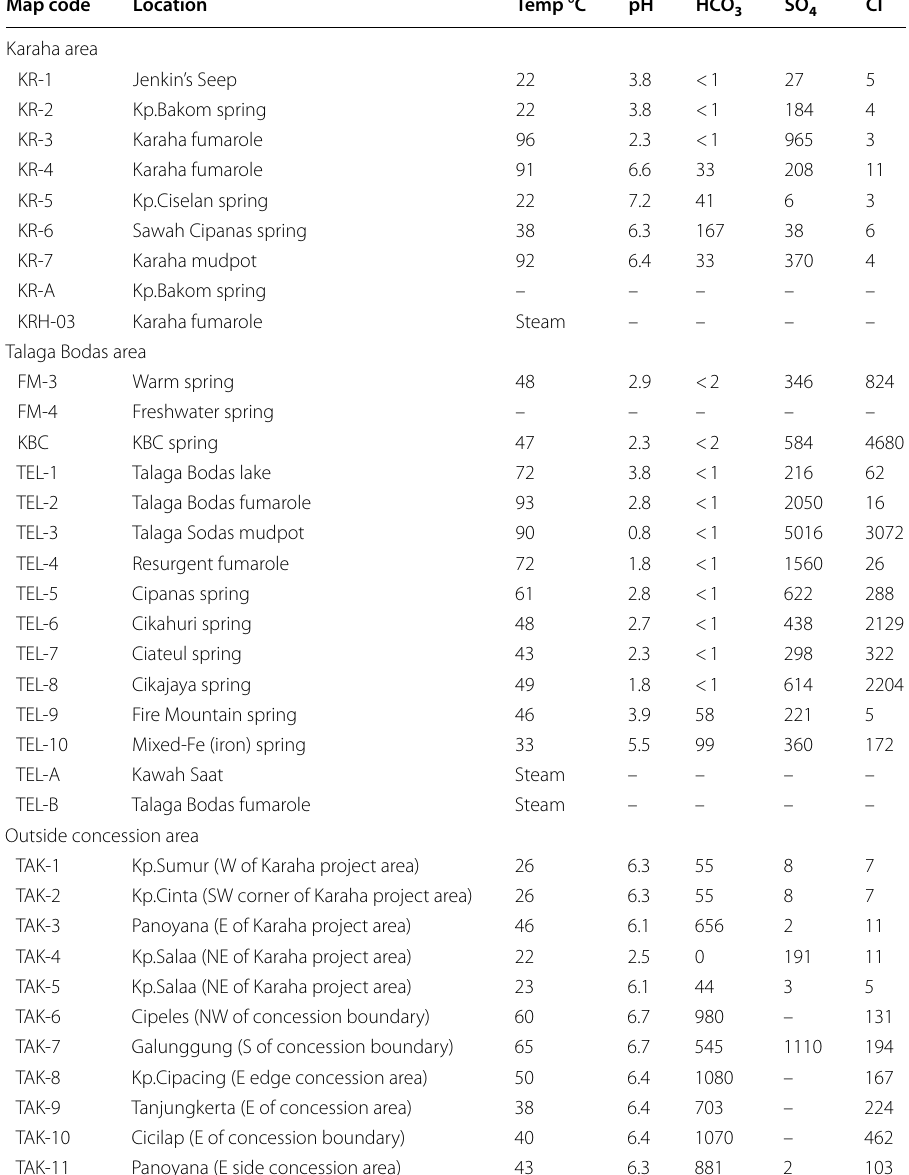
Table 1 Temperature, pH and chemical composition of surface manifestation sample of K– TB field. Modified from GeothermEx (1998) Map